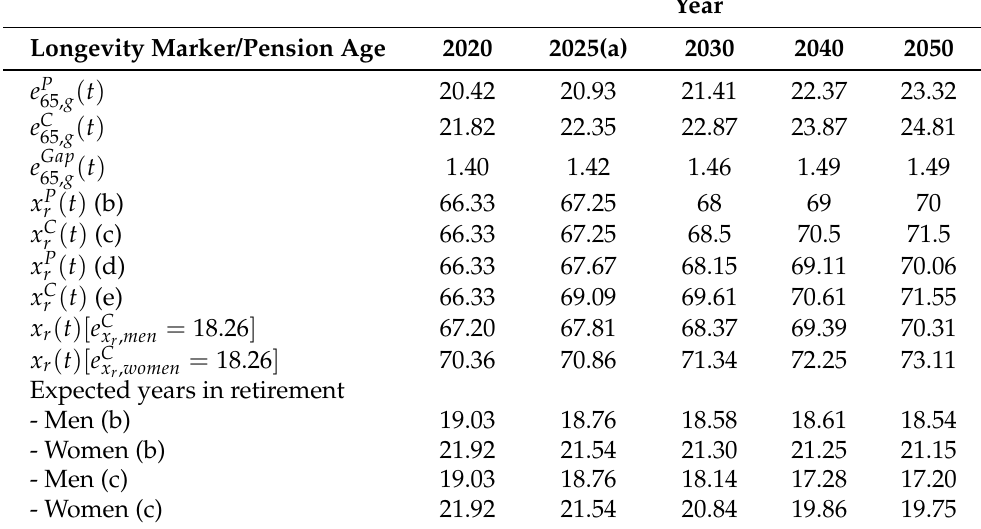
Table 2. NLD: Forecast of life expectancy and pension age